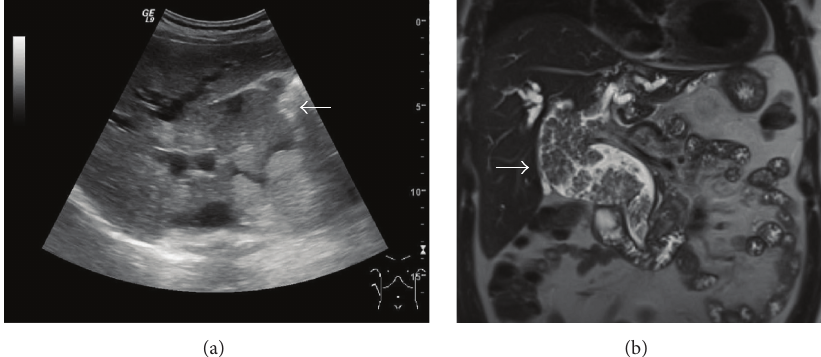
Figure 1: Preoperative imaging. (a) An ultrasonography and (b) MRCP revealed extensive papillary tumor in LHD, CHD, and CBD (arrow). LHD: left hepatic duct, CHD: common hepatic duct, and CBD: common bile